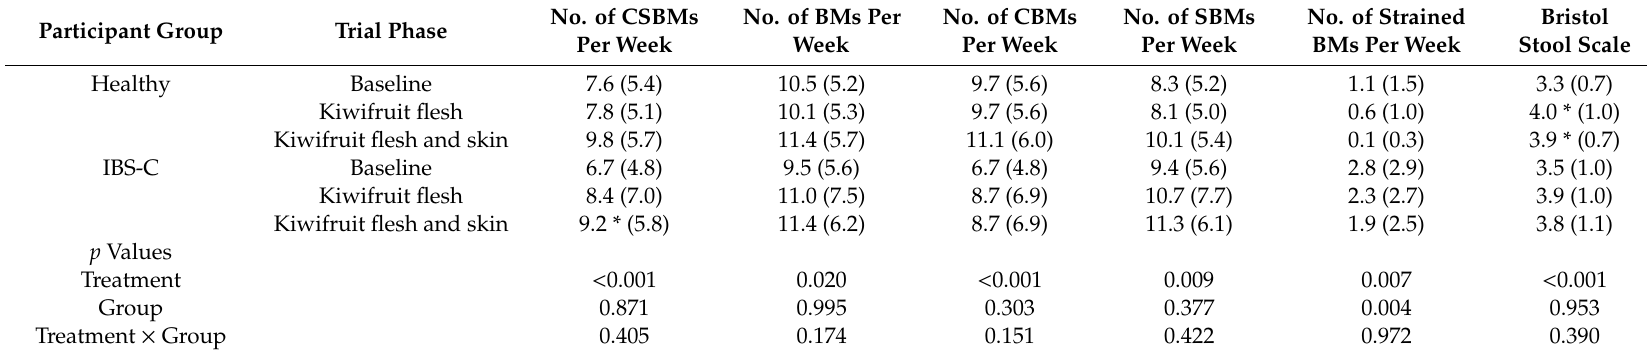
Table 4. Bowel movement (BM) frequency and Bristol Stool Scale results for participants consuming Zespri ® SunGold kiwifruit ( Actinidia chinensis var. chinensis ‘Zesy002’) with and without skin 1